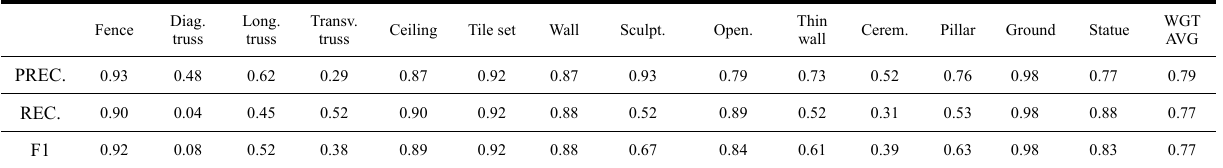
Table 6. RF non-hierarchical classification metrics for